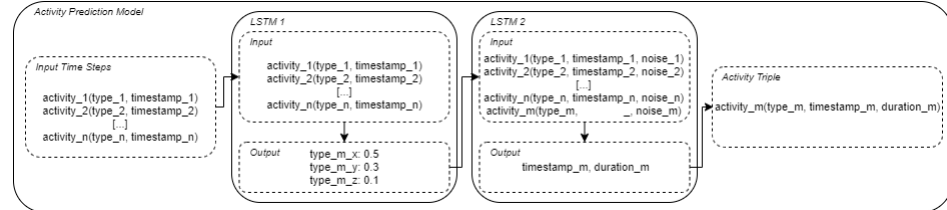
Figure 7. Activity Prediction Model